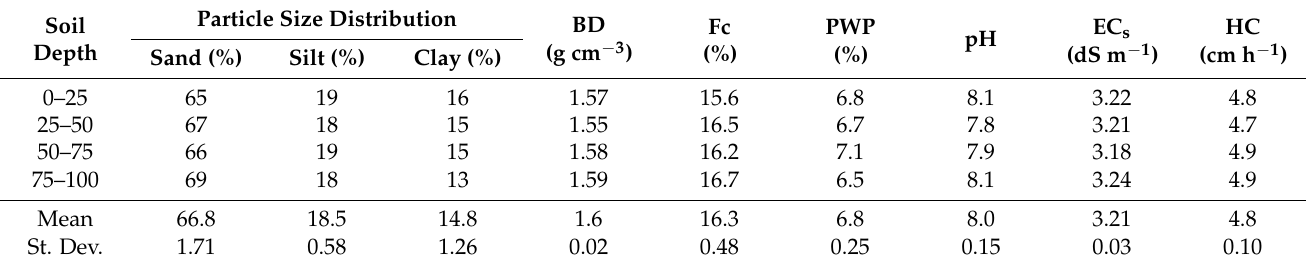
Table 1. Physical and hydraulic properties of the sandy loam soil in the experimental site.